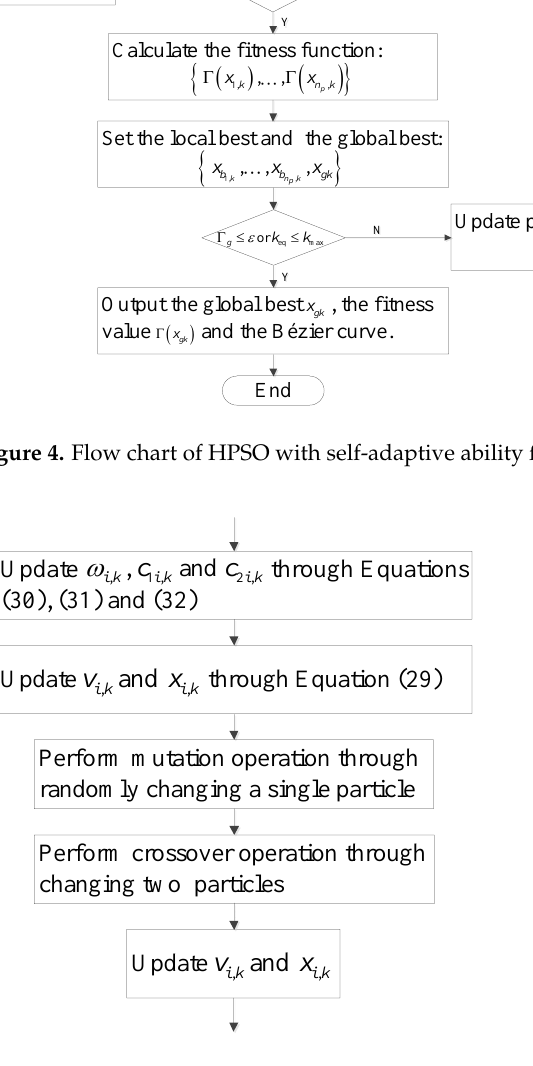
Figure 5. Velocity and position updating mechanisms of particles in